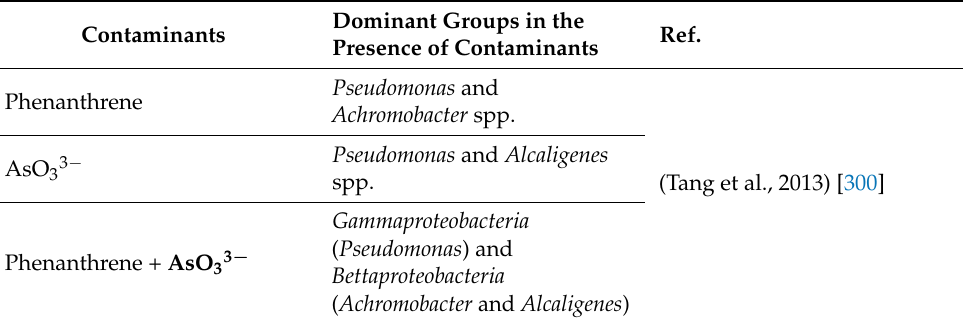
Table 4. Dominant taxa in the presence of